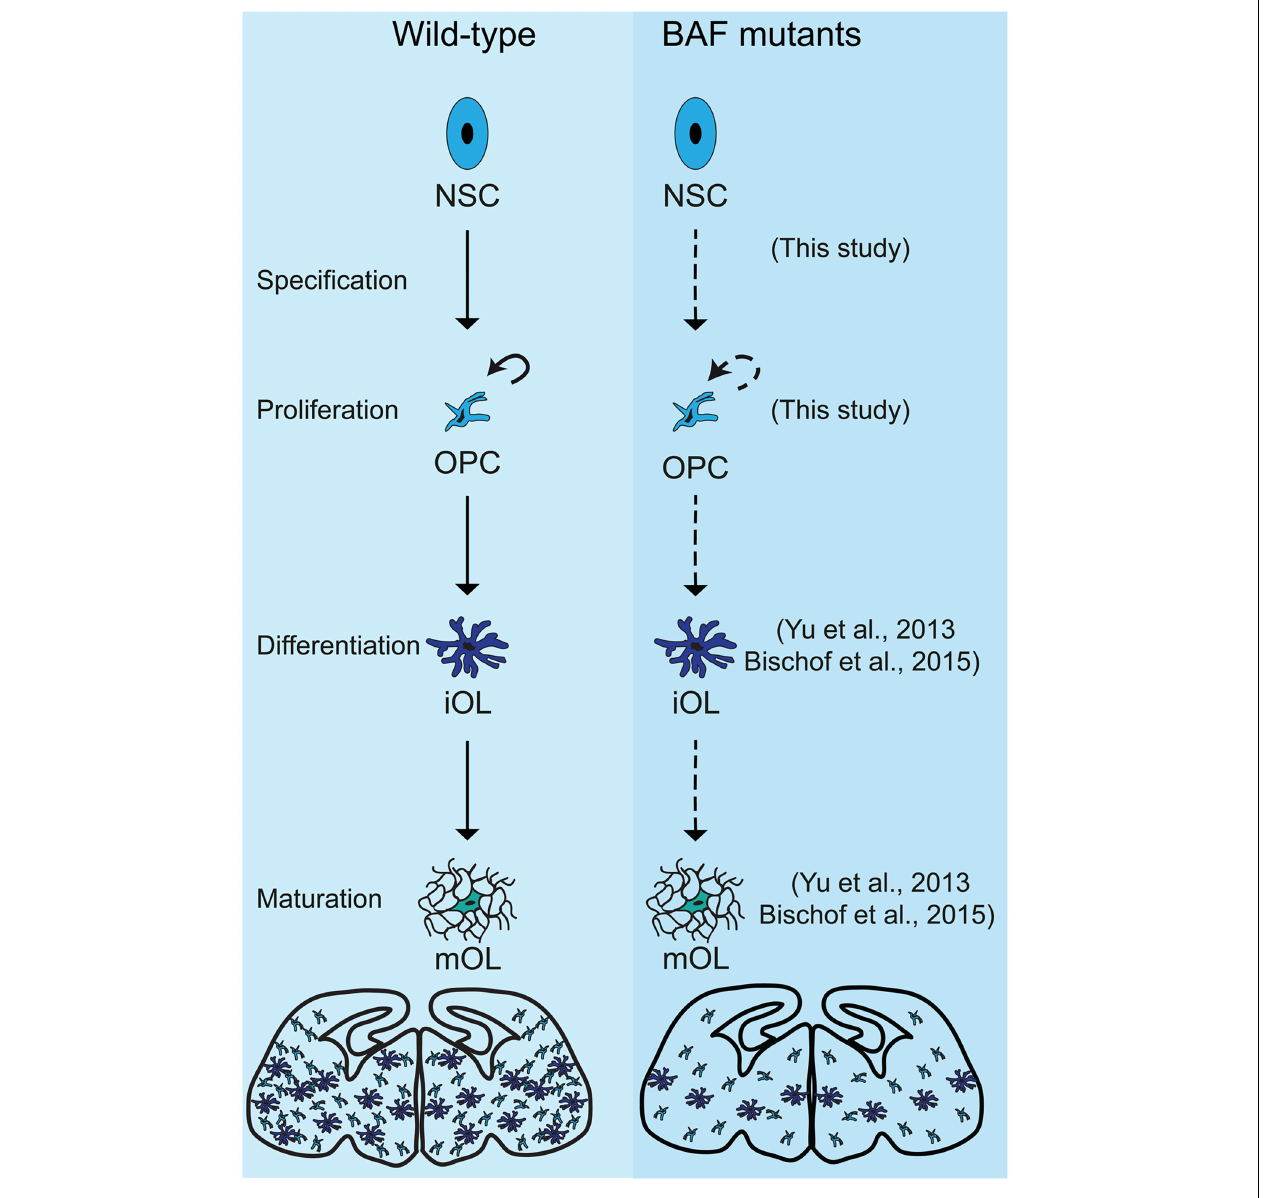
FIGURE 7 | Schema summarizing the effects of loss of chromatin remodeling BAF complex activity on oligodendroglial lineage progression in BAF155/BAF170dcKO and Brg1cKO mutants. The illustration shows a comparison of the progression of oligodendrocyte development in the developing mouse forebrain between control (Wild-type, in the left panel) and BAF mutants (in the right panel), i.e., BAF155/BAF170cKO mutants (this study) and Brg1cKO mutants (Yu et al., 2013; Bischof et al., 2015). In control, multipotent neural stem cell (NSC) gives rise to oligodendrocyte precursor cells, which are able to proliferate (shown by curved arrow) and differentiate into immature oligodendrocyte (imOL). The imOL undergoes maturation to become fully myelinating mature oligodendrocyte (mOL). However, in the absence of BAF155 and BAF170, the OPC is improperly specified from the mutant NSC and undergoes reduced proliferation (this study). In addition, in the absence of Brg1, OPCs were unable to differentiate and mature properly (Yu et al., 2013; Bischof et al., 2015). The diagrams at the end of the schema depict the overall depletion of OLs in the BAF mutant brain compared with control. References to key studies that reported phenotypes due to ablation of the BAF complex are indicated. Dashed-arrows are used to indicate defective developmental